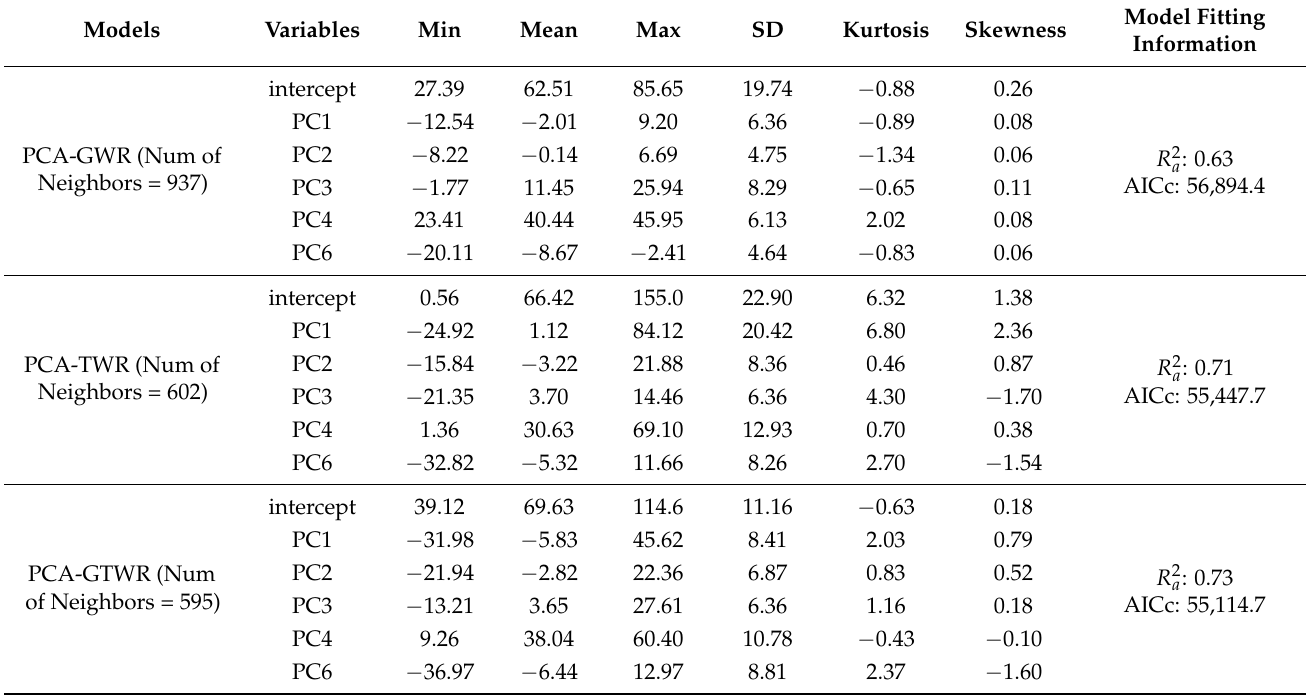
Table 5. PCA-GWR, PCA-TWR, and PCA-GTWR parameter estimates of PM 10 (the models are fitted by an adaptive neighbor selection algorithm).